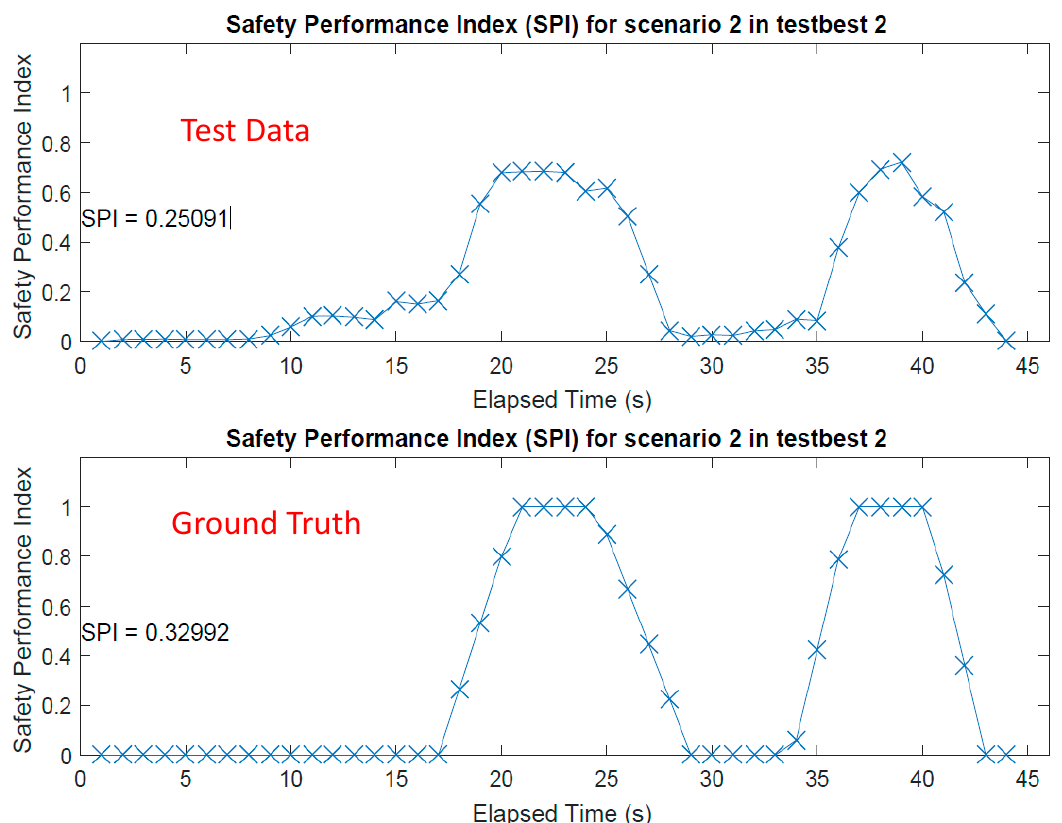
Figure 11. Comparison of safety performance indices for test data and ground truth.